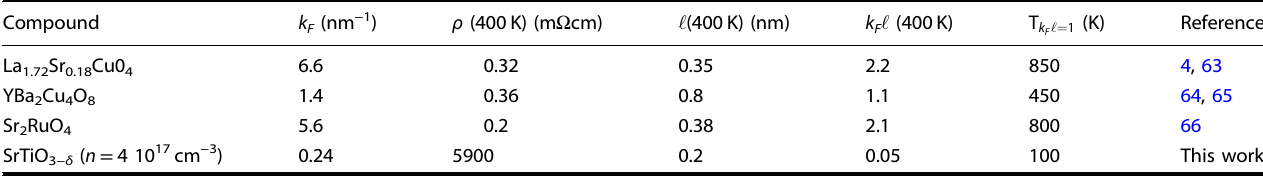
Table 1. How the MIR limit of metallicity is exceeded in different perovskytes Compound